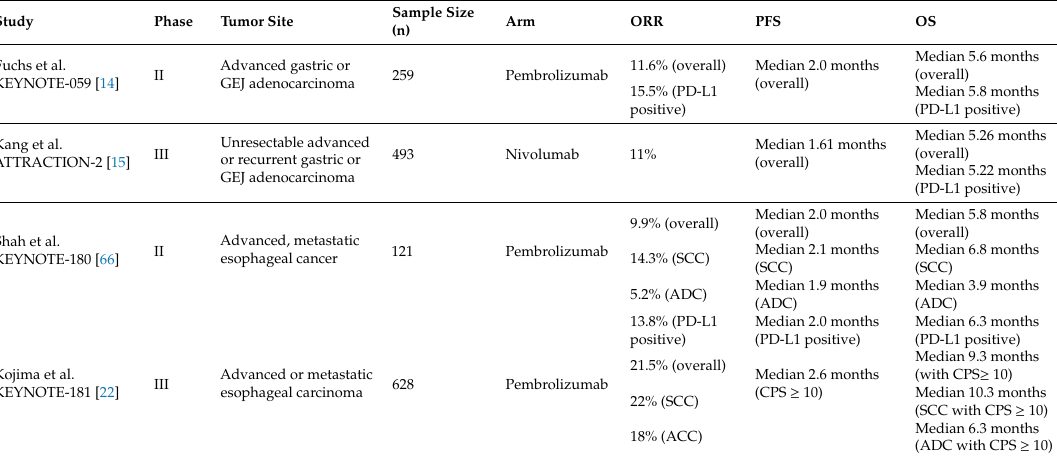
Table 4. PD-1 / PD-L1 status and therapeutic targets (selected